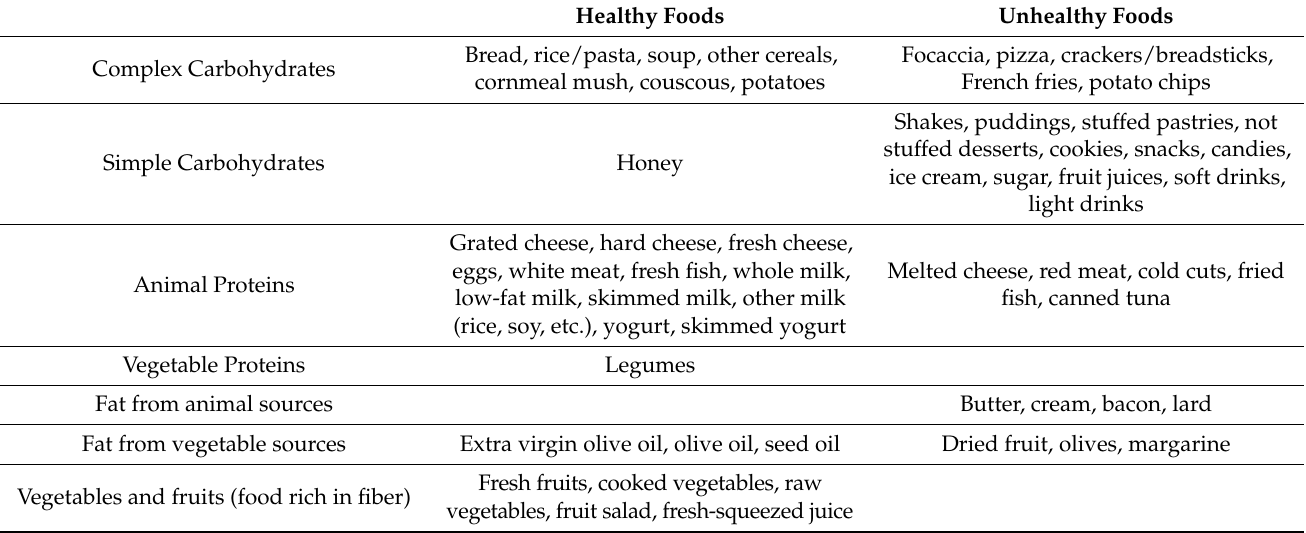
Table 1. Food groups according to Mediterranean dietary pattern and NOVA classification. Healthy Foods Bread, rice/pasta, soup, other cereals, cornmeal mush, couscous,